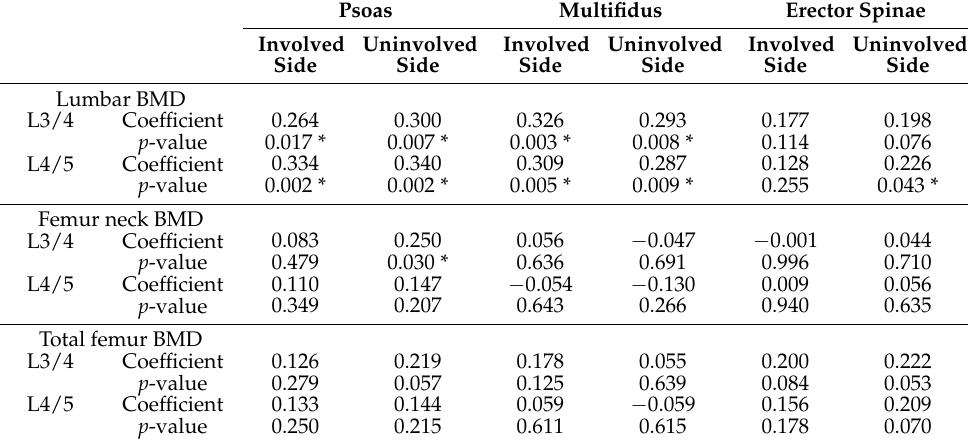
Table 3. Pearson correlation analysis to analyze the correlation between the FCSA of lumbar spinal muscles and lumbar BMD.